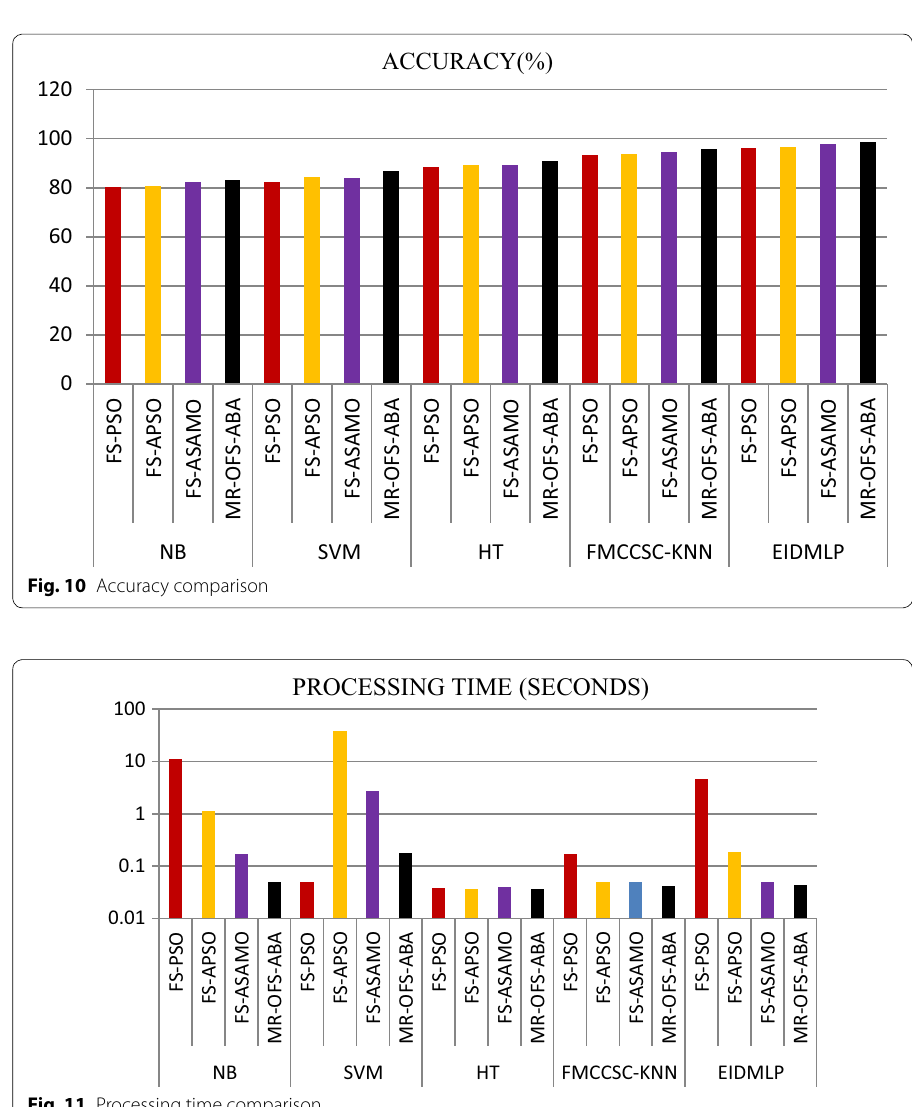
Fig. 11 Processing time